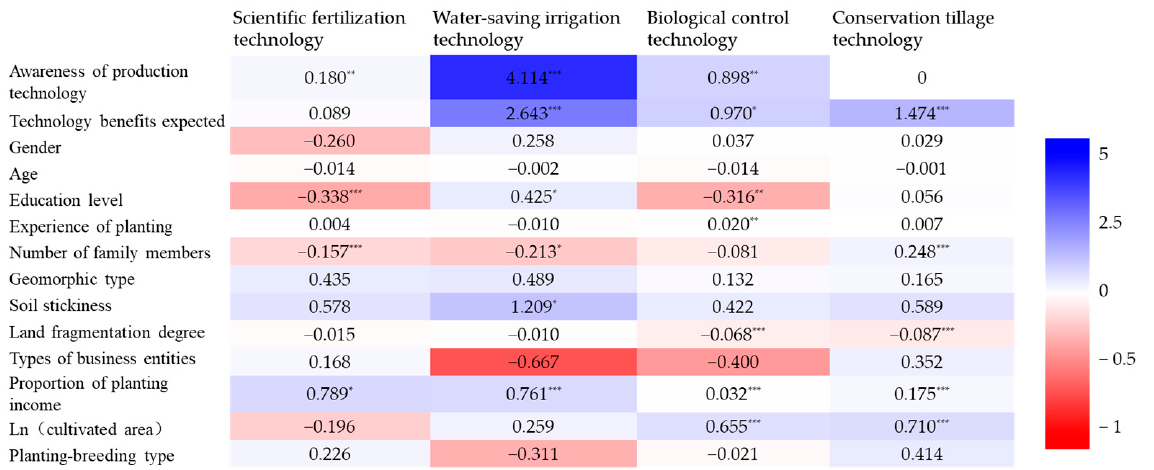
Figure 3. A summary of the regression results between the different green production techniques. Red, white, and blue represent the negative, zero, and positive coefficients, respectively. The darker the color, the greater the absolute value of the coefficient. *, **, *** indicate the statistical significance at the 10%, 5%, and 1% levels, respectively.